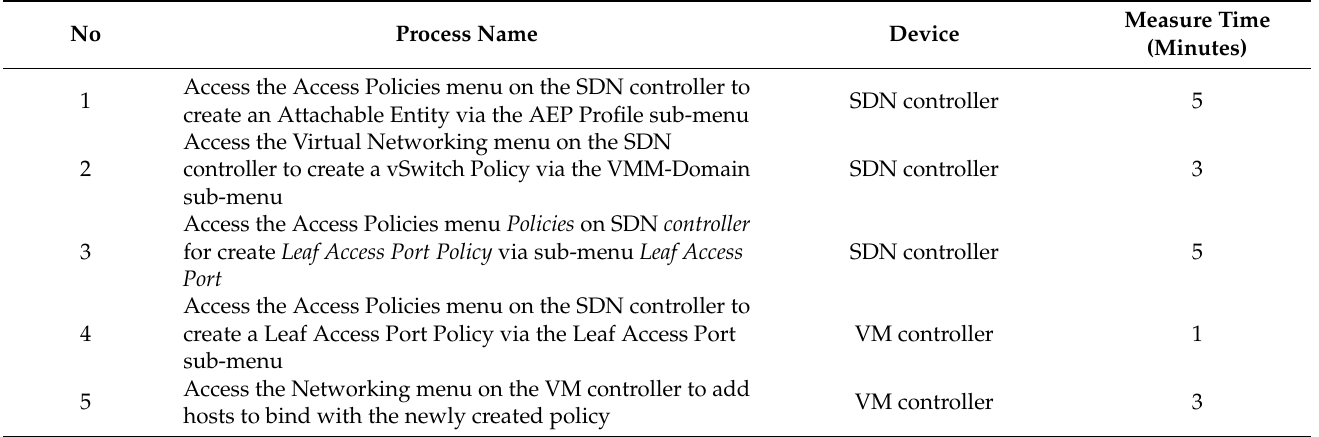
Table 10. Integrated policy increment measurement time for VM via SDN controller.